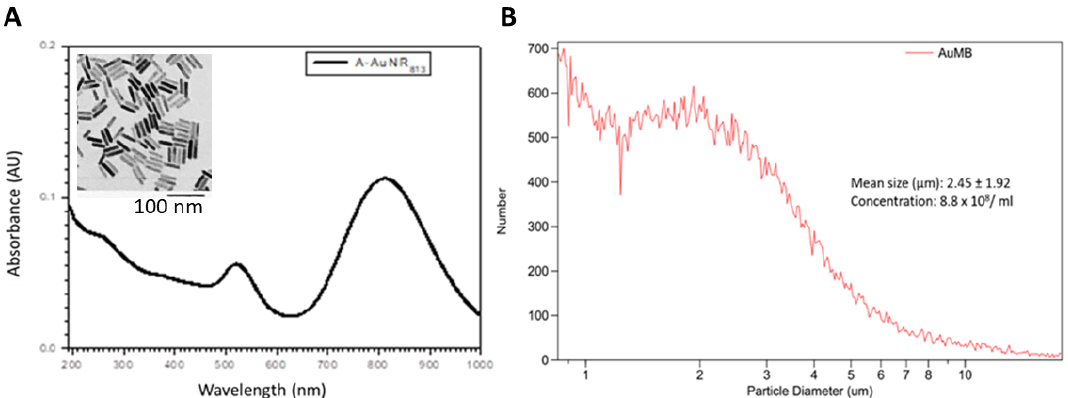
Figure 2. Characterization of god nanoparticles (AuNPs) and AuNP-encapsulated microbubbles (AuMBs). ( A ) The optical absorption peaked at 813 nm. The inset transmission electron microscopy image accurately shows the aspect ratio of the rod-shaped AuNPs. ( B ) Size distribution of the AuMBs.